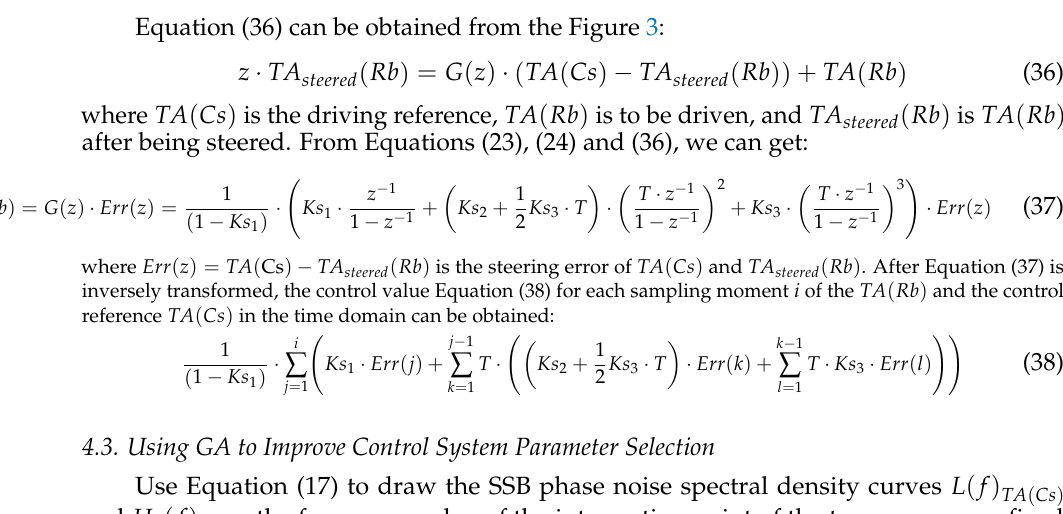
Figure 3. The functional block diagram of the equivalent DPLL steering control system.